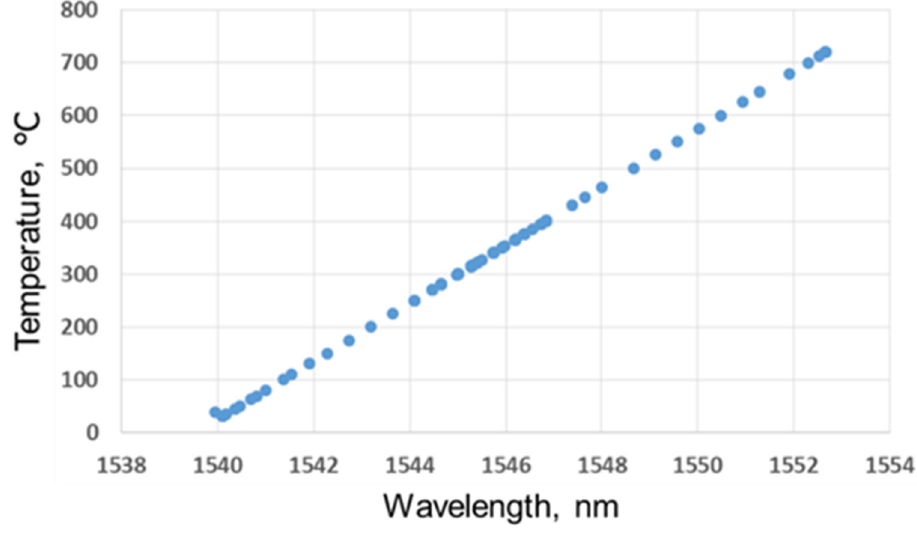
Figure 8. FBG sensor calibration.